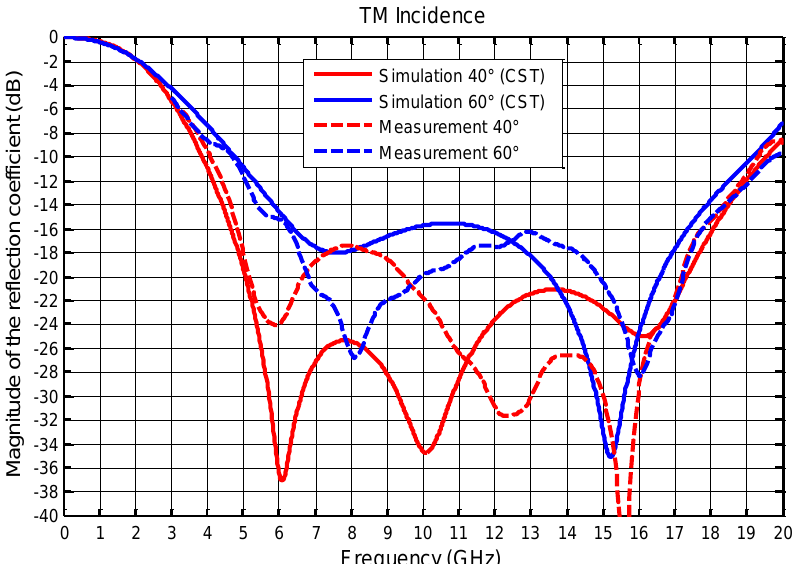
Figure 7. Comparison between the simulated and measured magnitudes of the reflection coefficient (dB) as a function of frequency with two angles of incidence 40° and 60° for TM polarization.